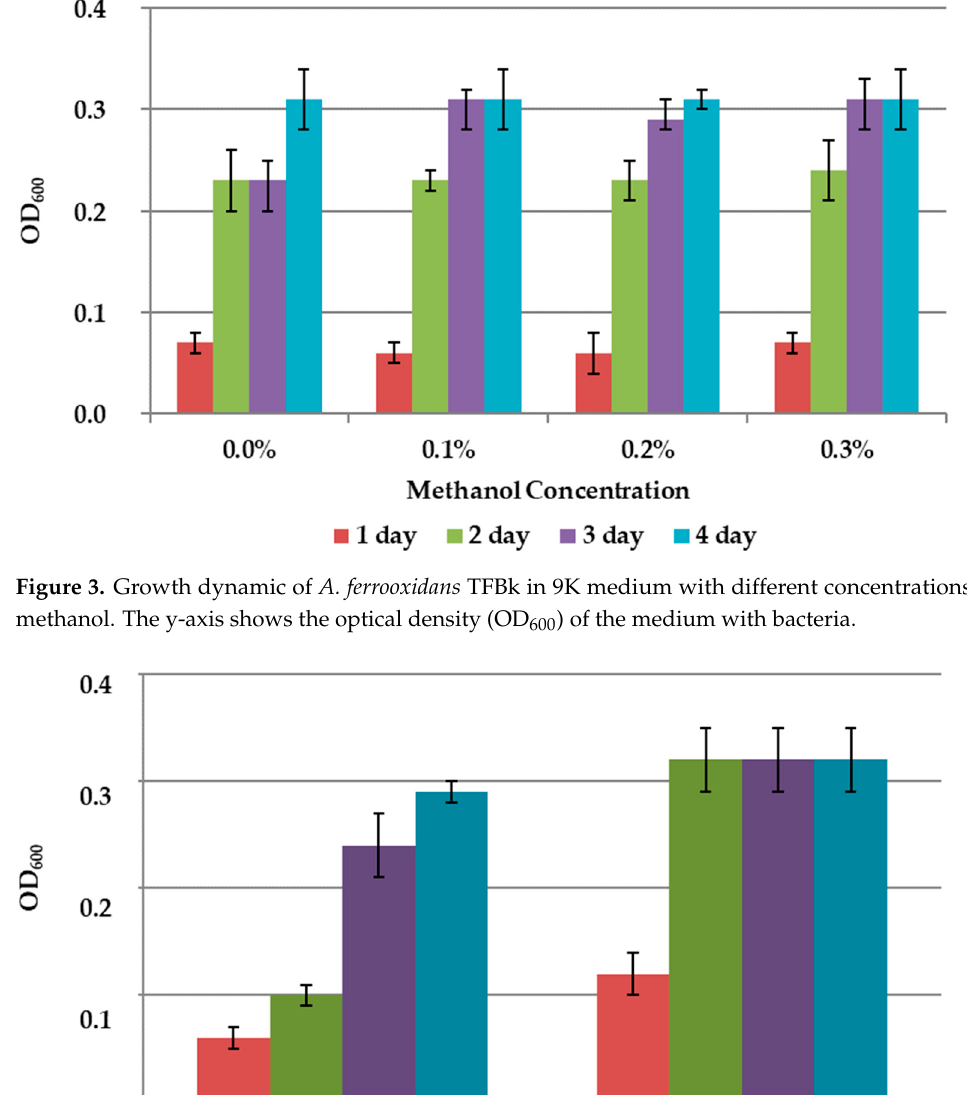
Table 4. The effect of formate and methanol additions on the leaching of iron and sulfates from a sample of arsenopyrite concentrate by A. ferrooxidans TFBk bacteria. Control is the leaching in the medium without addition of formate and methanol.